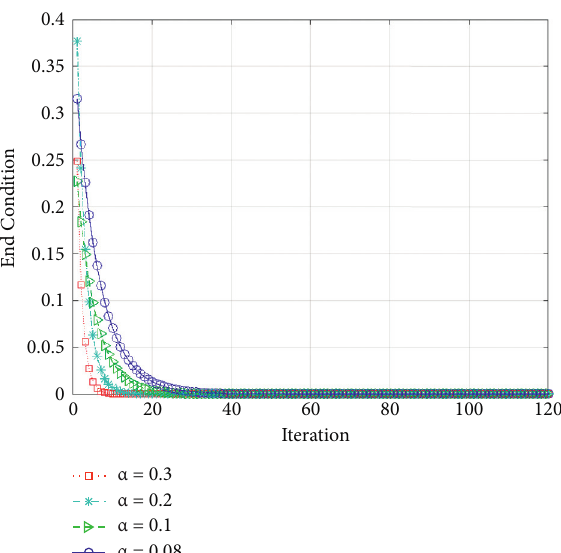
Figure 3: Convergence performance of Algorithm 2 under asynchronous integration